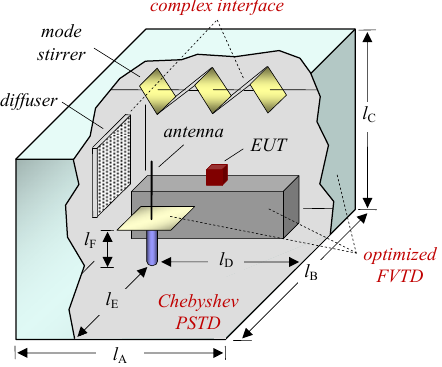
Figure 22: A general mode-stirred reverberation chamber. Modeling regions: complex-interface schemes for the